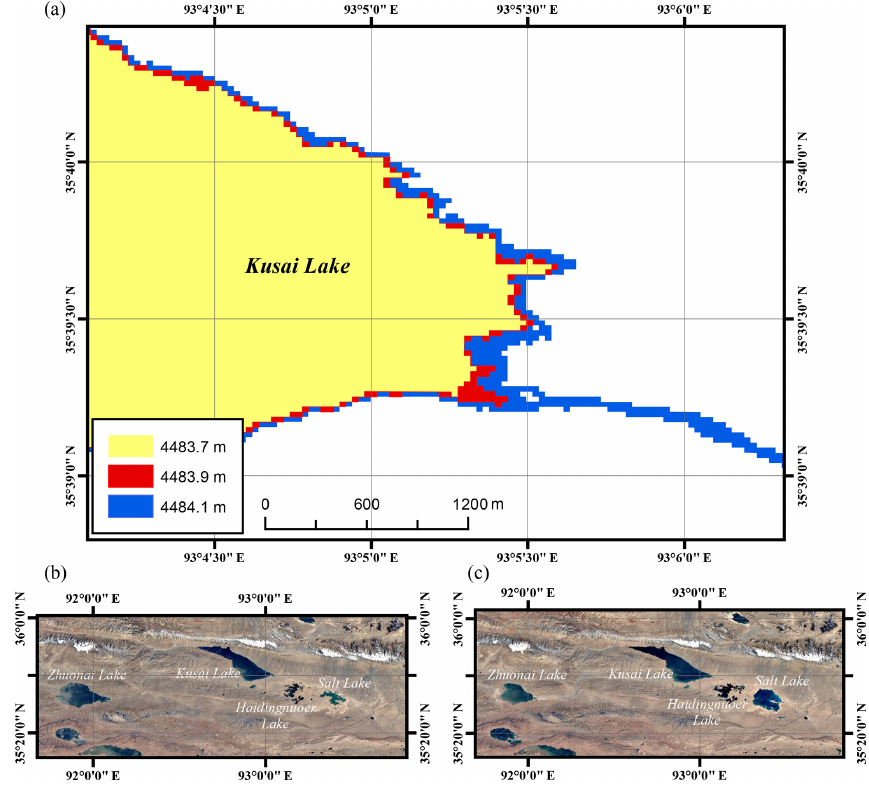
Figure 18. (a) Height variations in the outlet of Lake Kusai estimated from Landsat 8 OLI images indicate that the overflow would occur when the water level increased from 4483.9 to 4484.1m. (b) Google Earth© image before the outburst of Lake Zhuonai (December 2010). (c) Google Earth© image after the outburst event (December